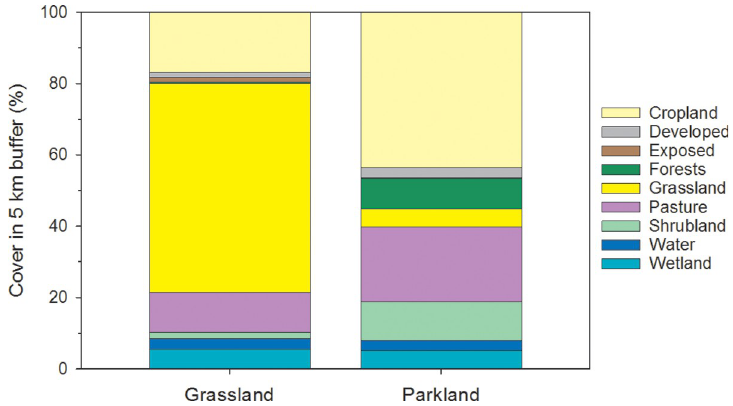
Fig 3. Comparison of study wetlands in the Grassland and Parkland natural regions. Values represent the average composition of each of 9 land-cover classes surrounding wetlands in the Grassland ( n = 24) and Parkland ( n = 24) measured within a 5 km symmetrical